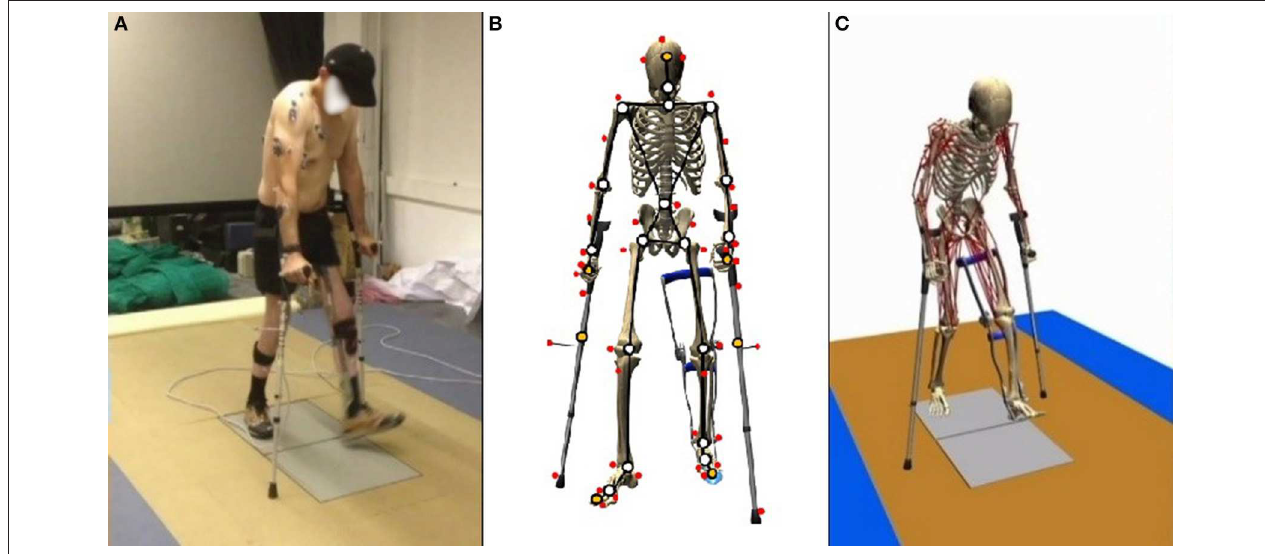
FIGURE 1 | Gait of SCI subject assisted by passive orthoses and crutches: (A) motion-force-EMG capture; (B) skeletal model; and (C) musculoskeletal model.